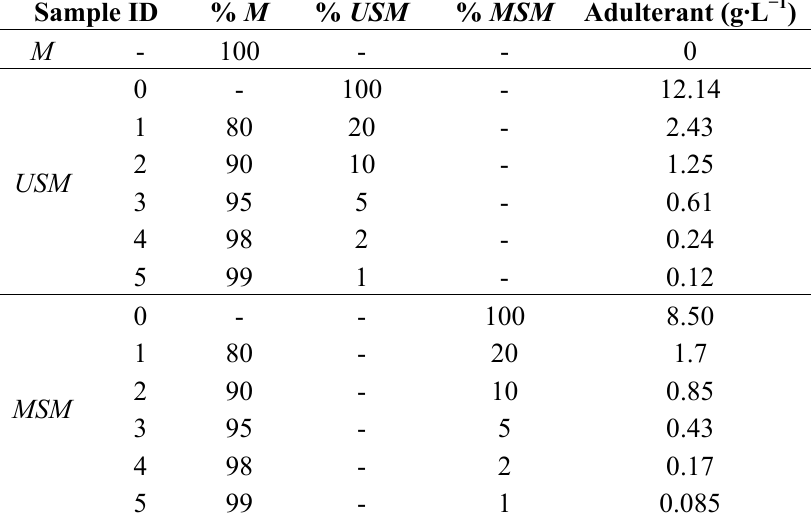
Table 1. Composition of adulterated and non-adulterated milk samples. M : Milk, USM : Urea synthetic milk, MSM : Melamine synthetic milk. Adulterated samples (1 to 5) were prepared by mixing a percentage of M and the correspondent “synthetic milk” ( USM ). The quantity of adulterant (urea or melamine according to each case) is indicated MSM 0 in g·L − 1